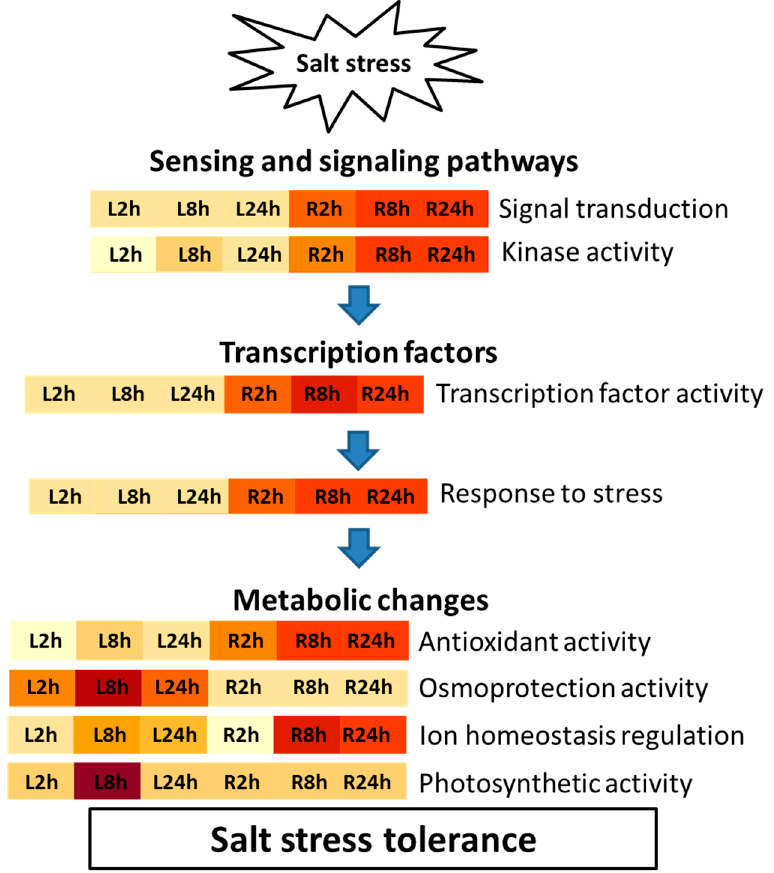
Figure 6. Flow chart of the salt stress tolerance mechanism in barley. The induced stress response begins with the activation of several sensing and signaling pathways, followed by transcriptional reprograming, resulting in the activation of diverse cellular homeostasis mechanisms for ROS detoxification, osmoprotection, ion homeostasis, and photosystem protection. Samples L2h, L8h, and L24h and R2h, R8h, and R24h for leaves and roots, respectively, under different stress durations are shown. The color gradient indicates the pattern of GO term enrichment level from low (yellow) to high (brown).